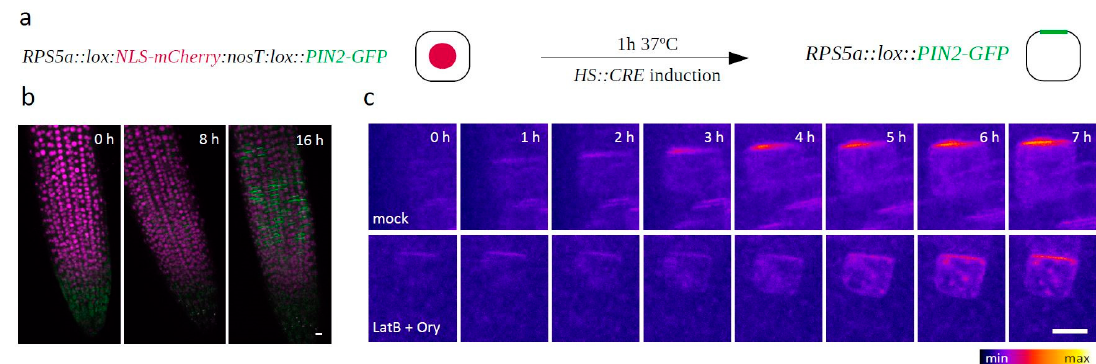
Figure 2. ( a ) Schematic depiction of the RPS5a::lox:NLS-mCherry:nosT:lox::PIN2-GFP construct generated to monitor PIN2-GFP polarity establishment in interphase cells. ( b ) Merged red and